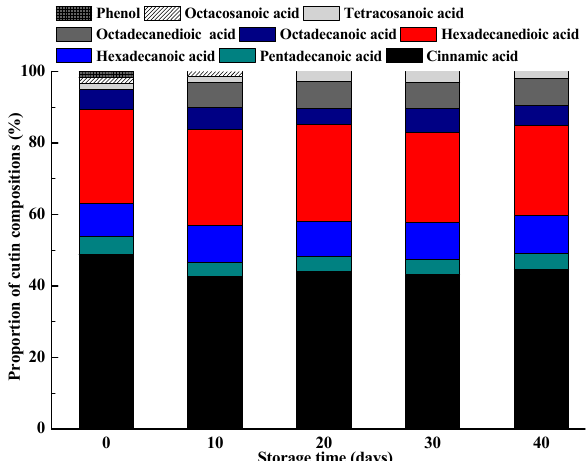
Figure 3. Cutin monomers composition proportion of the ‘Satsuma’ mandarin fruits during storage.